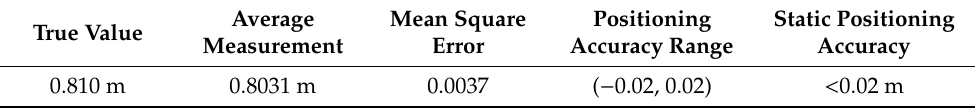
Table 1. Analysis of static positioning measurement data when two base stations are 50 m apart.